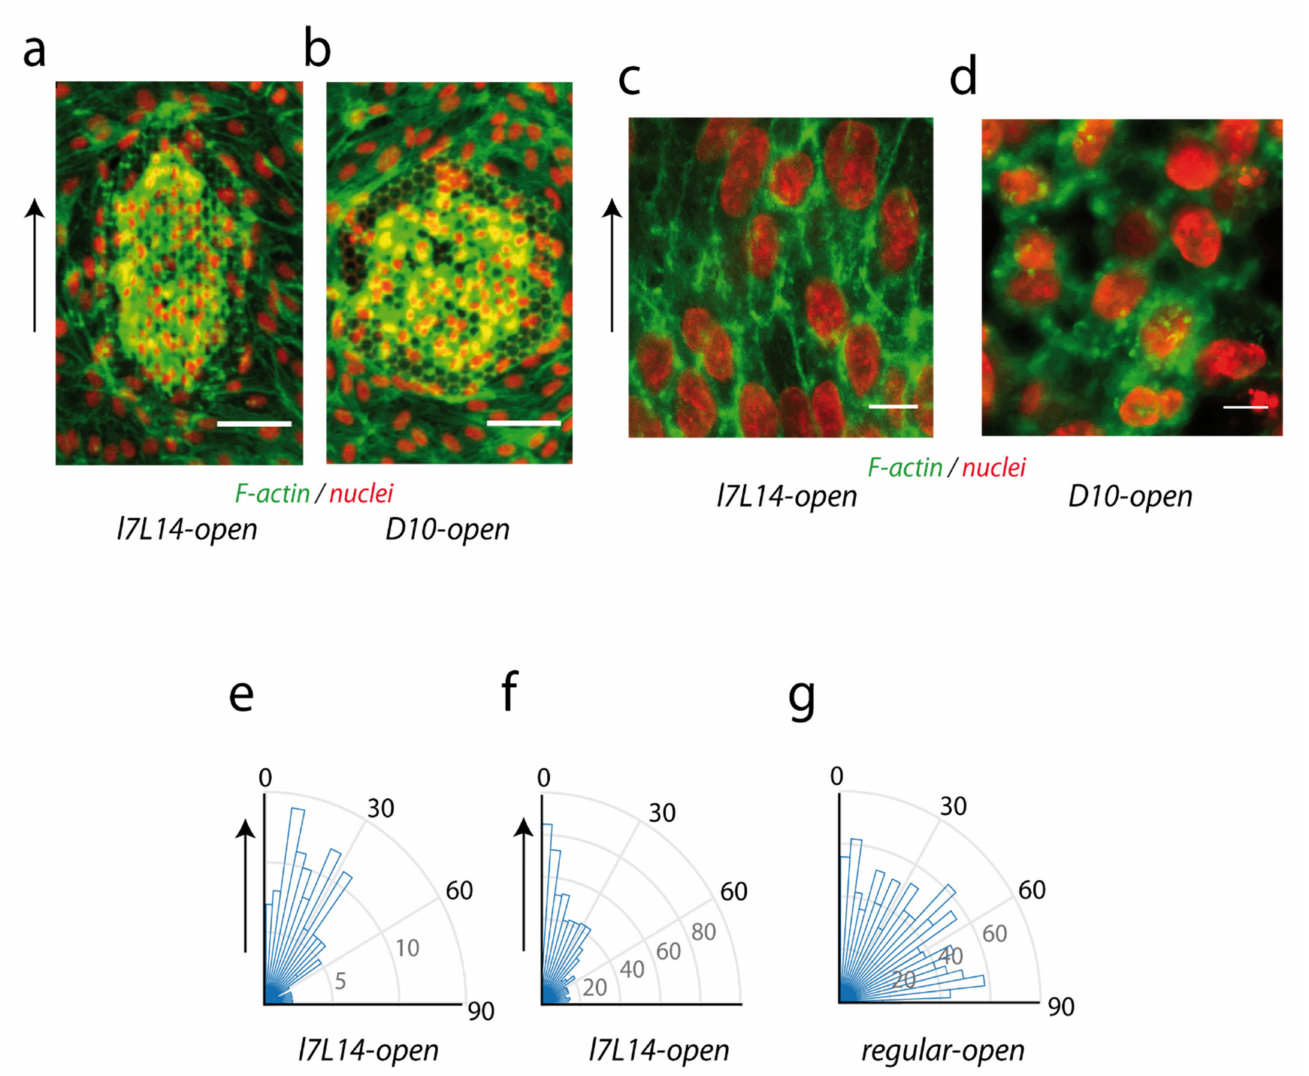
Figure 2. Cellular organization in the top monolayer. ( a , b ) Global HUVECs coverage of ( a ) l7L14-open and ( b ) D10-open microstructures. VEGF 0.5 ng/mL. z projection is shown, red: nuclei, green: F-actin, bar 50 µ m. ( c , d ) Detail of the top monolayer covering ( c ) l7L14-open , with the axis of elongation of hexagons represented by a black arrow (top, left), and ( d ) regular D10-open microstructures. Red: nuclei, green: F-actin, z projection of planes above structures, cells fixed at time of structure colonization (2 ( b , d ) or 3 ( a , c ) days after cell seeding). Scale bar 10 µ m. ( e – g ) Histograms of nuclei orientations in the top layer above the microstructures. Only the part of the nuclei above 4 µ m height was considered. ( e ) l7L14-closed (127 nuclei in 7 structures) ( f ) l7L14-open (700 nuclei in 15 structures) ( g ) D4.5 , D6.6 , D8.8 , D10 , and D13.5-open microstructures (1051 nuclei in 23 structures). Vertical arrows in ( a , c , e , f ) represent the reference axis for elongated structures. For regular structures, the reference axis was chosen perpendicular to one size of the hexagon (not